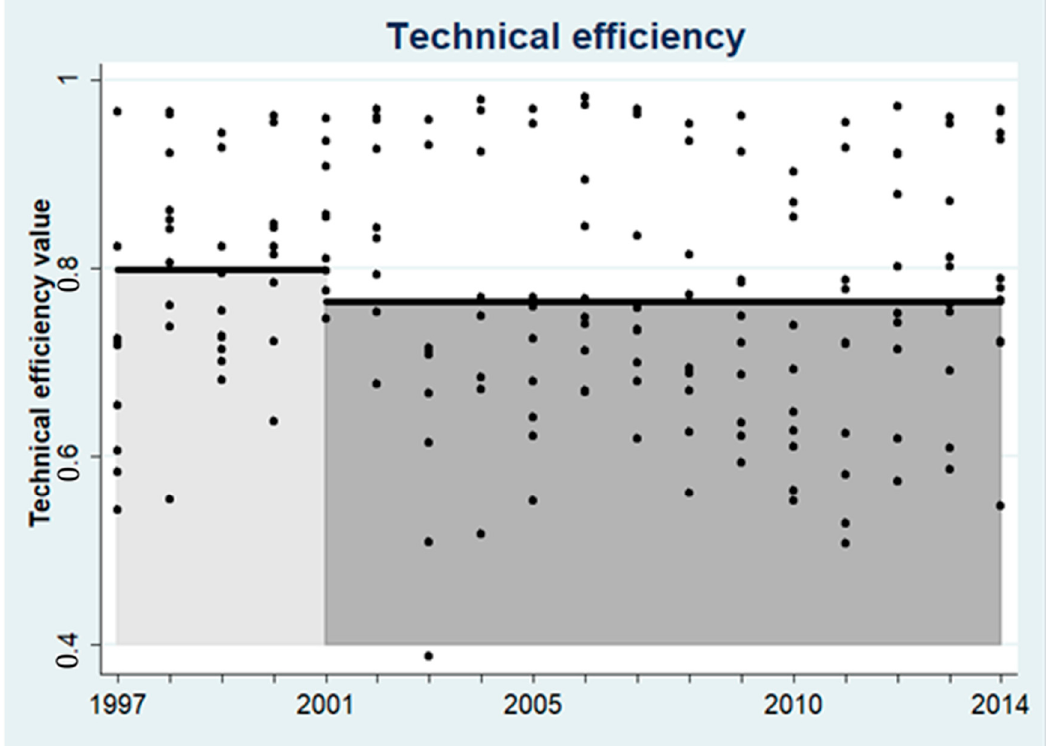
Figure 3. Dynamic of technical efficiency before and after Bt technology adoption.